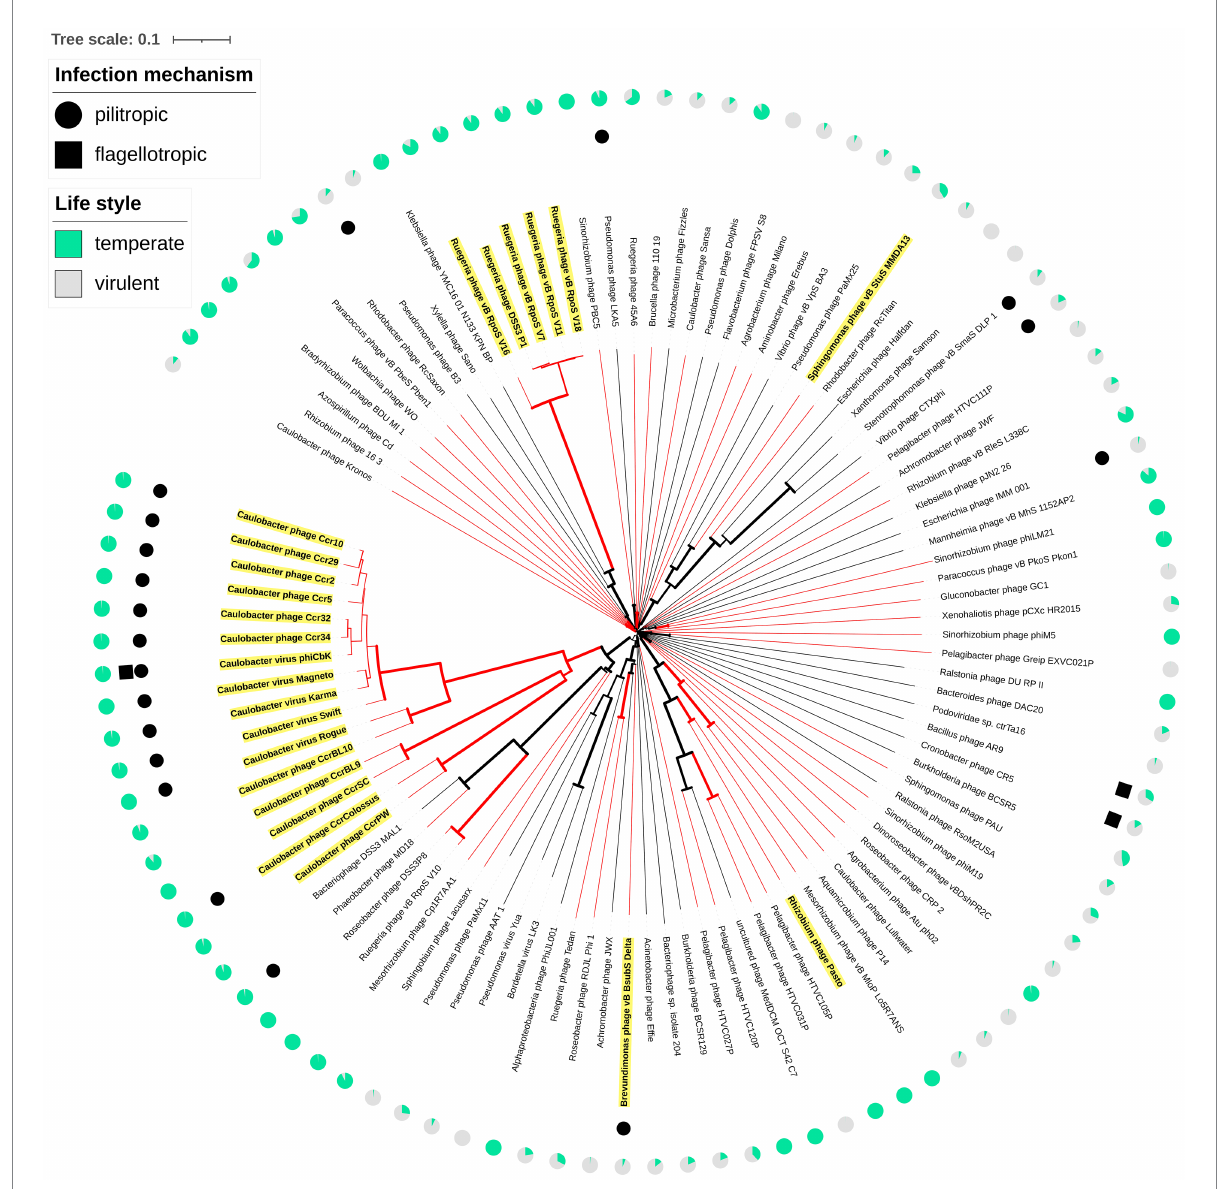
FIGURE 3 Whole-genome phylogeny of vB_BsubS-Delta. Whole-proteome tree of complete bacteriophage genomes. The tree was generated with FASTML using BLAST-derived inter-genomic distances using VICTOR. Midpoint rooting was applied for circular visualization. Bootstrap support values are shown as branch widths, with the thickest branches corresponding to 100% bootstrap support. The branches corresponding to Alphaproteobacteria-infecting phages are colored in red. External filled circles and squares designate, respectively, known pilitropic and flagellotropic phages (Supplementary Table S4). Names for LPEG phages (Supplementary Table S7) are highlighted in yellow. External pie-charts indicate (green) the probability of temperateness assigned by the BACPHLIP algorithm (Supplementary Table